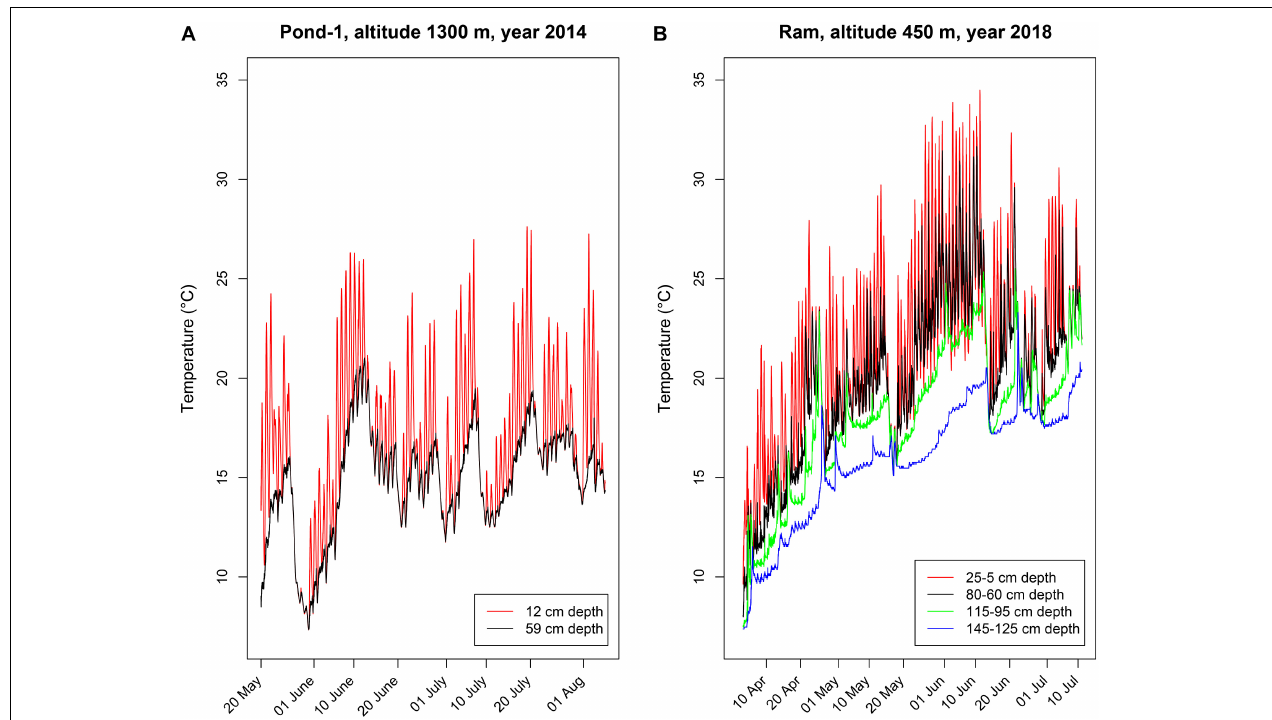
FIGURE 1 | Depth-specific time series of water temperatures in two shallow freshwater systems inhabited by Polynucleobacter asymbioticus . Loggers deployed in different water depths measured temperatures in 30-min intervals. (A) Water temperatures measured in Pond-1, the home habitat of strain QLW-P1DMWA-1 T . This shallow pond (maximum depth ∼ 1.2 m) is located at an altitude of 1300 m. (B) Water temperatures measured in four different water depths in a shallow (maximum water depth 1.5 m) bog pond located in Schönramer Moor. Designated here as Ram, this pond is located at an altitude of 450 m and 35 km away from Pond-1. The water level dropped by 20 cm during the investigation period in summer, which changed the water depths in which the loggers were moored. Note the diurnal changes in water temperature in the upper water layers, which frequently show amplitudes of more than 5 ◦ C of warming and nocturnal cooling with